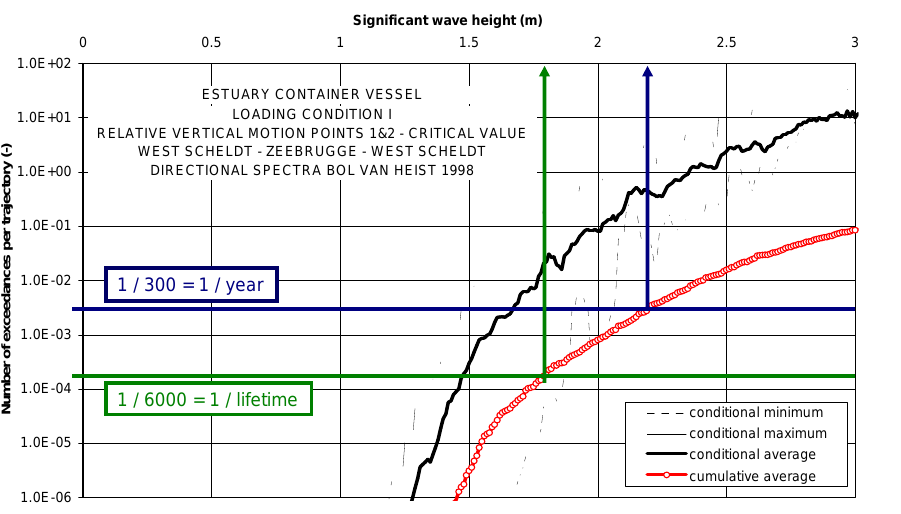
Figure 7. Example of a plot showing the relation between the actual significant wave height and the (conditional) minimum, maximum and average number of times a given critical level is expected to be exceeded during a crossing, as well as the relation between the maximum allowable significant wave height and the (cumulative) average number of times the critical value is expected to be exceeded during any crossing (Vantorre et al,